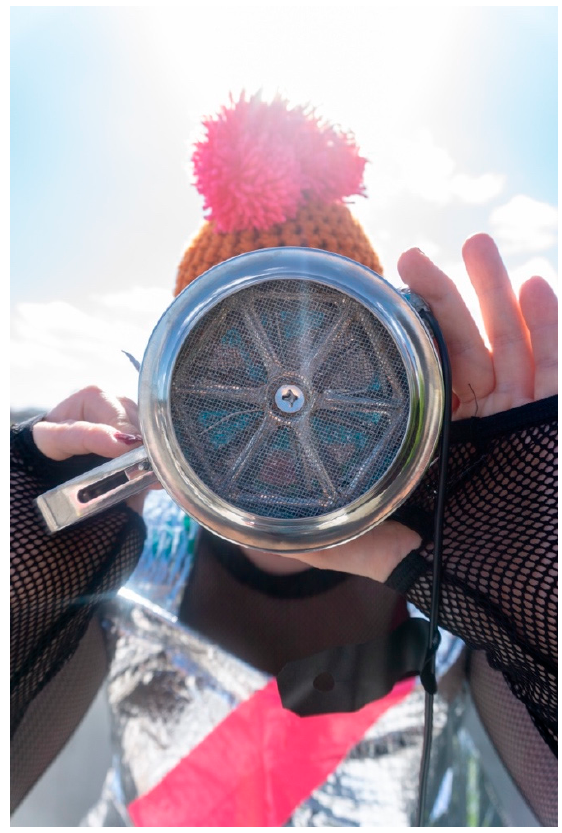
Figure 10. A participant of the group, Sonic Electric, re-positioning a flour sifter in a Public Kitchen,